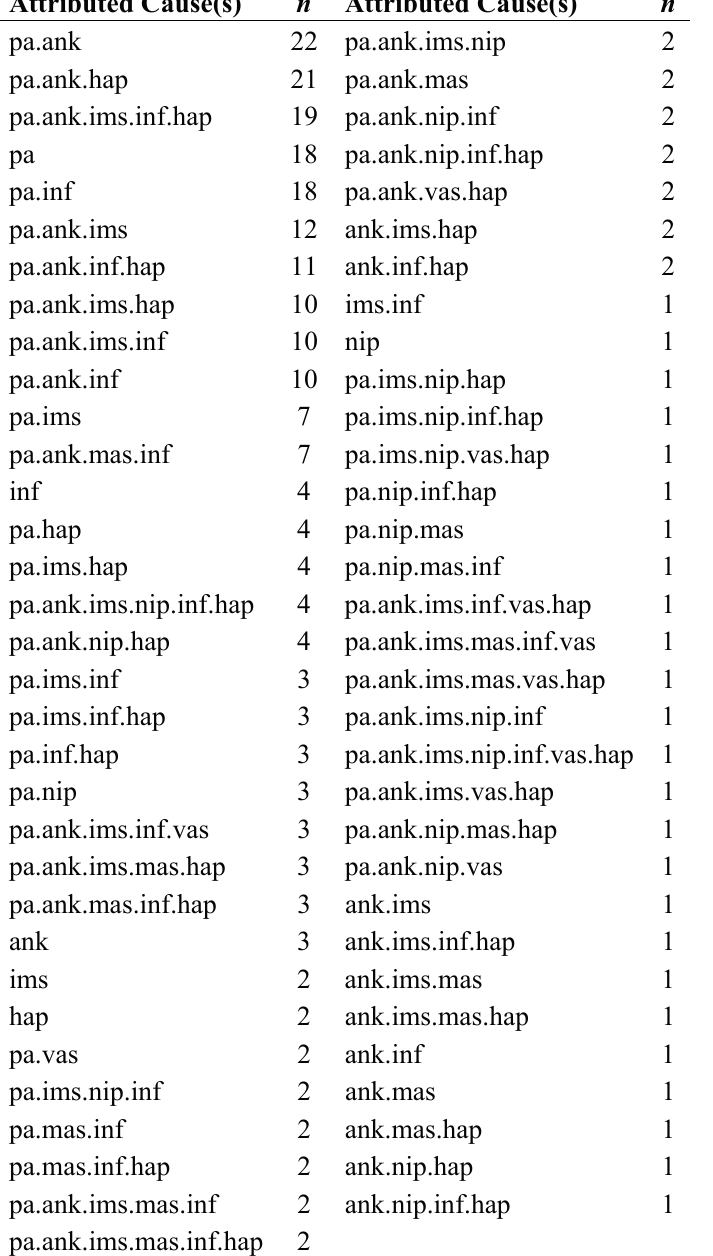
ank ims ank.ims.mas hap pa.vas 2 ank.inf pa.ims.nip.inf 2 ank.mas pa.mas.inf 2 ank.mas.hap pa.mas.inf.hap ank.nip.hap pa.ank.ims.mas.inf 2 ank.nip.inf.hap